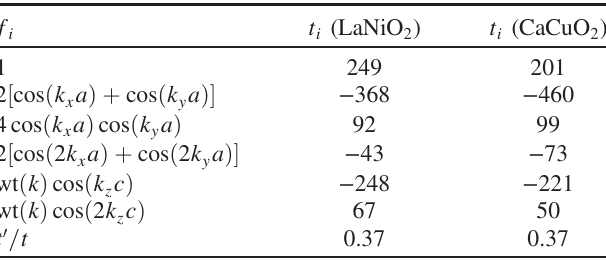
TABLE II. Tight binding fits for the d energy for CaCuO 2 and LaNiO 2 , along with the ratio t 0 =t